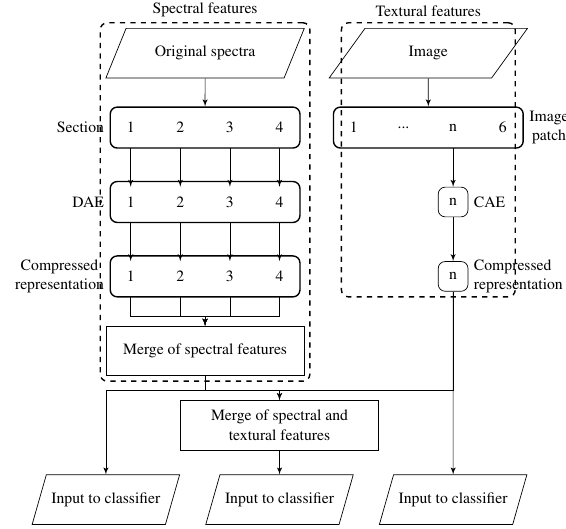
Figure 3. Data processing flow for one material sample, either for the spectral features, the textural features or the combination using the original